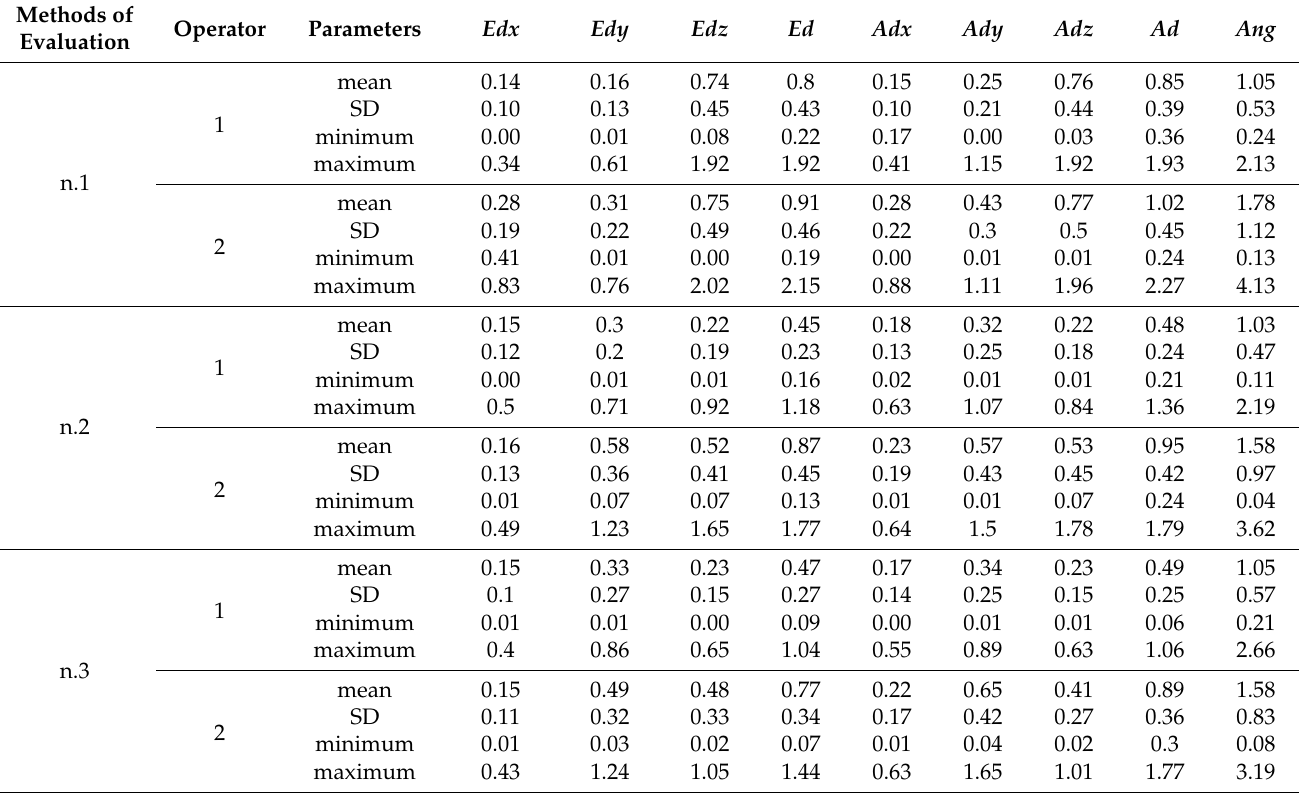
Table 2. Means, SDs (Standard Deviations), and extreme values for each operator from the three meth- ods of